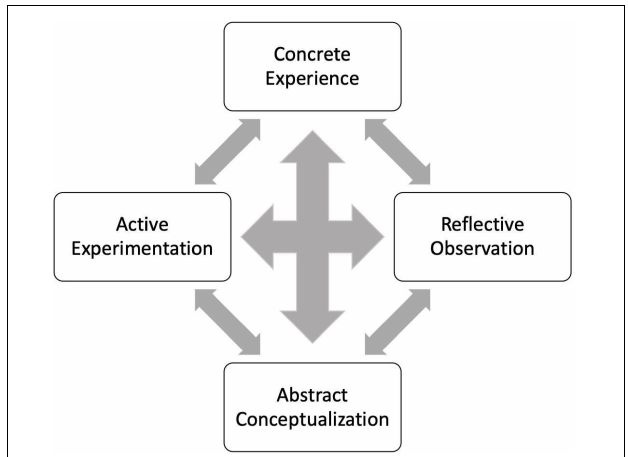
FIGURE 1 | Authors’ proposed reconceptualization of the fluid and recursive nature of Kolb and Kolb’s (2005)